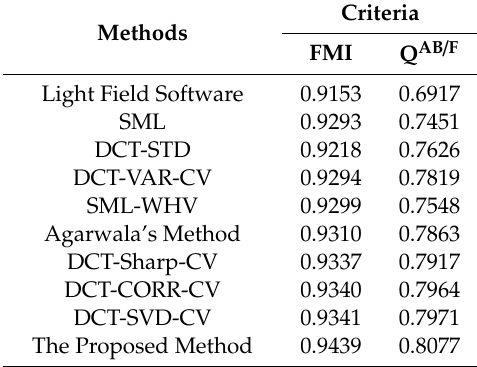
Figure 15. Comparison of ‘Mouse’ image results: ( a ) Light Field Software, ( b ) SML, (c) DCT-STD, ( d ) DCT-VAR-CV, ( e ) SML-WHV, ( f ) Agarwala’s method, ( g ) DCT-Sharp-CV, ( h ) DCT-CORR-CV, ( i ) DCT-SVD-CV, ( j ) The Proposed Method. Table 4. Objective evaluation of the image results (non-reference fusion metrics) for ‘Mouse’ image.